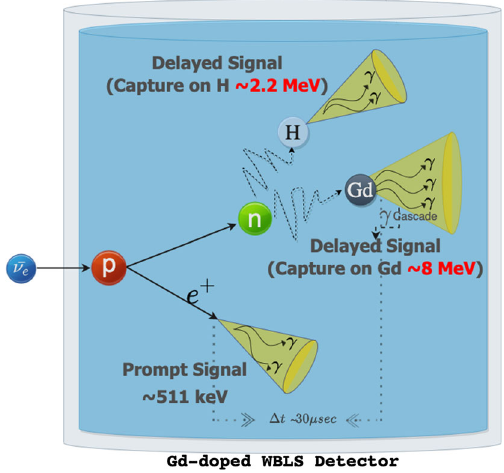
Fig. 1 Inverse beta decay (IBD) process and signal reconstruction in the Gd-doped water-based liquid scintillator (WbLS) detector